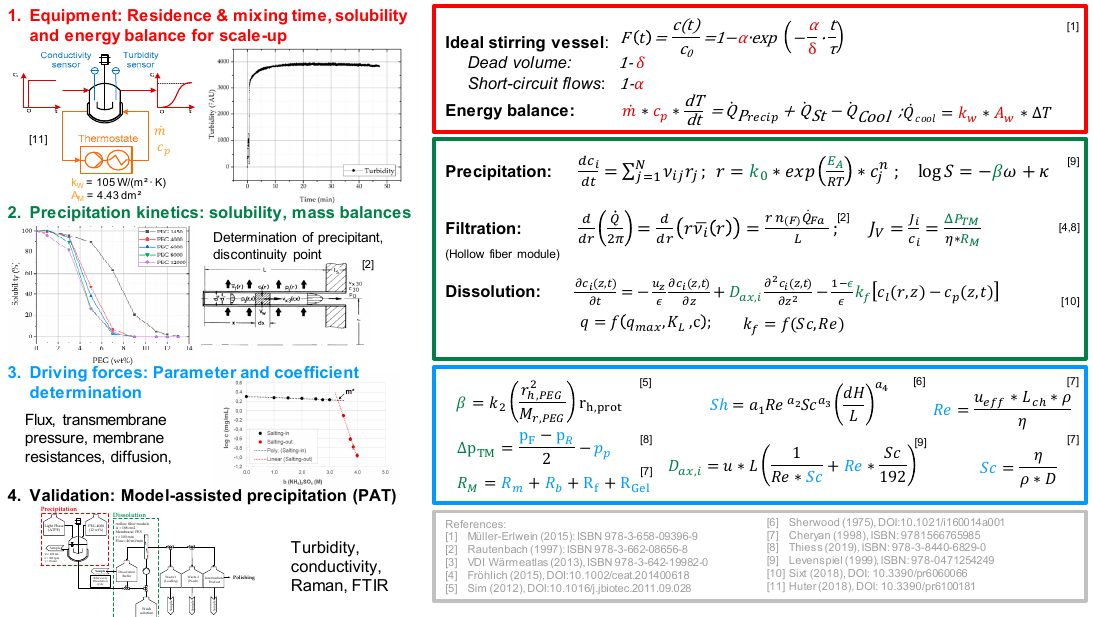
Figure 15. Model development and validation concept for the implementation of physico-chemical process models in biologics manufacturing. Concept is shown for the unit operation precipitation.